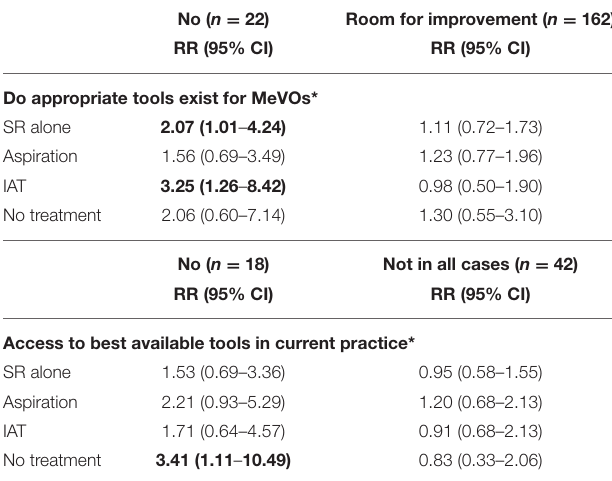
TABLE 3 | Likelihood of preferred first-line approach (stent-retriever, combined stent-retriever and aspiration, aspiration, intra-arterial thrombolysis, or other) by physicians’ opinion on whether the appropriate tools to treat MeVO exist, or whether they have access to the best available